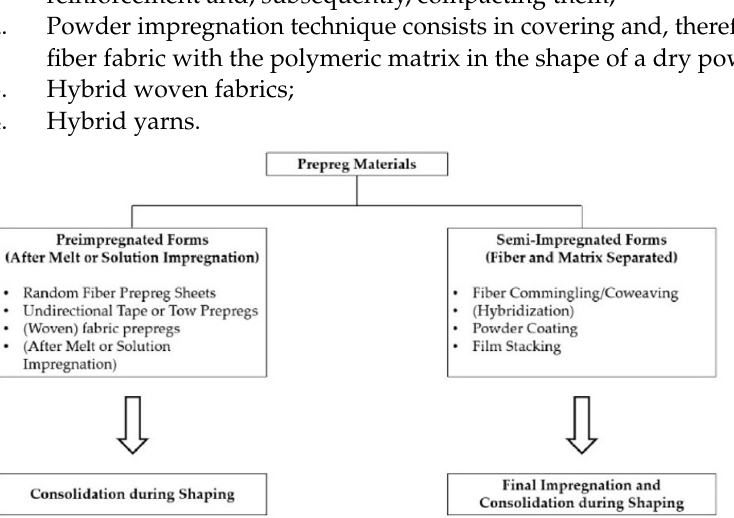
Figure 3. Typical impregnation techniques for thermoplastic composites materials. Authors’ own figure from Reference [6].